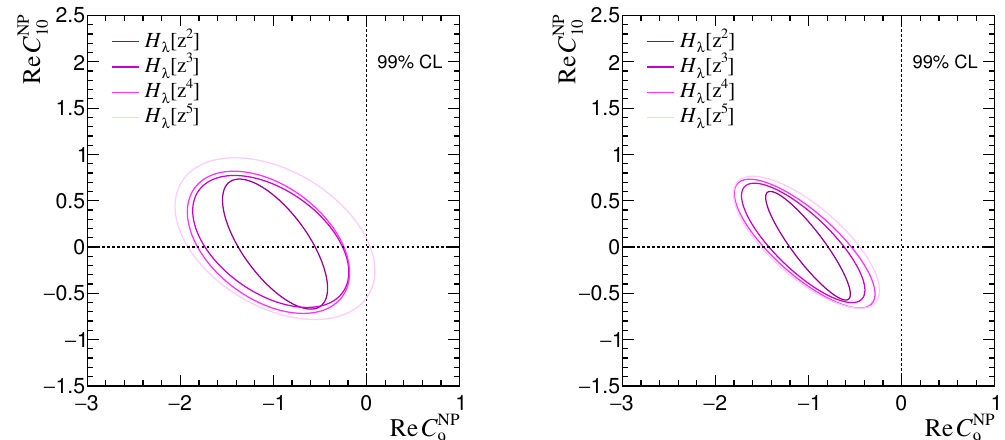
Figure 5 . Two-dimensional sensitivity scans for the pair of Wilson coe(cid:14)cients C NP di(cid:11)erent non-local hadronic parametrisation models. The contours correspond to 3 (cid:27) statistical- only uncertainty bands evaluated with the expected statistics after LHCb Run II (left) and LHCb Upgrade [50 fb (cid:0) 1 ] (right).